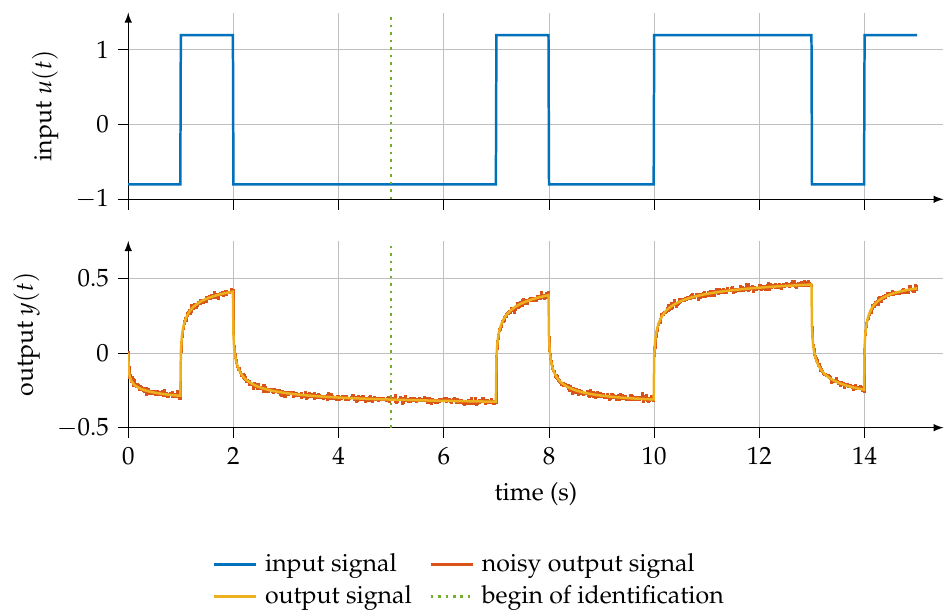
Figure 1. Input and output signals for parameter